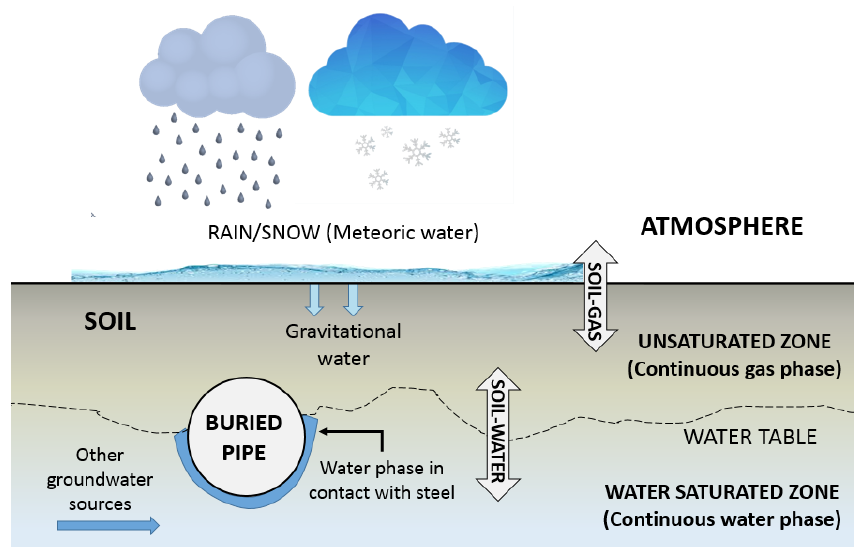
Figure 2. Buried pipe exposure of the surrounding soil. Modified from Jack and Wilmott